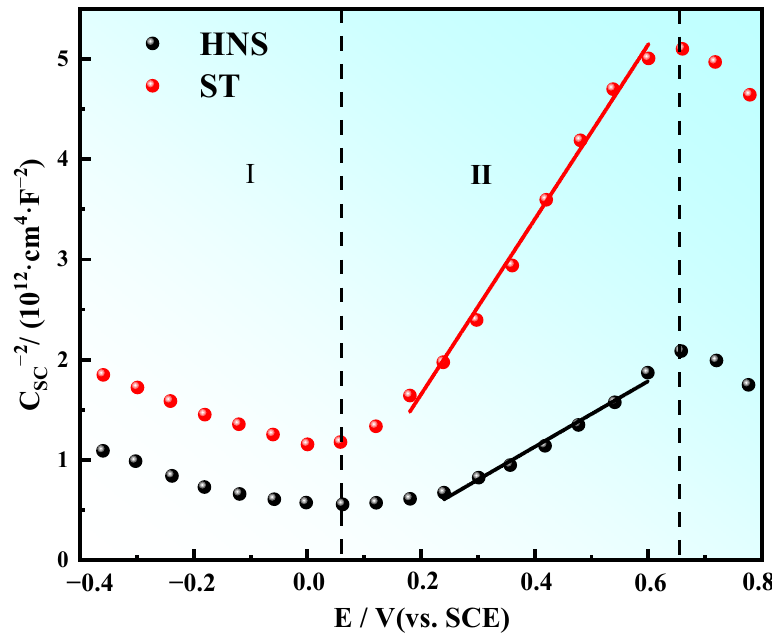
Figure 9. Mott-Schottky curves for HNS and ST. Table 3. Donor densities of passive films formed on HNS and